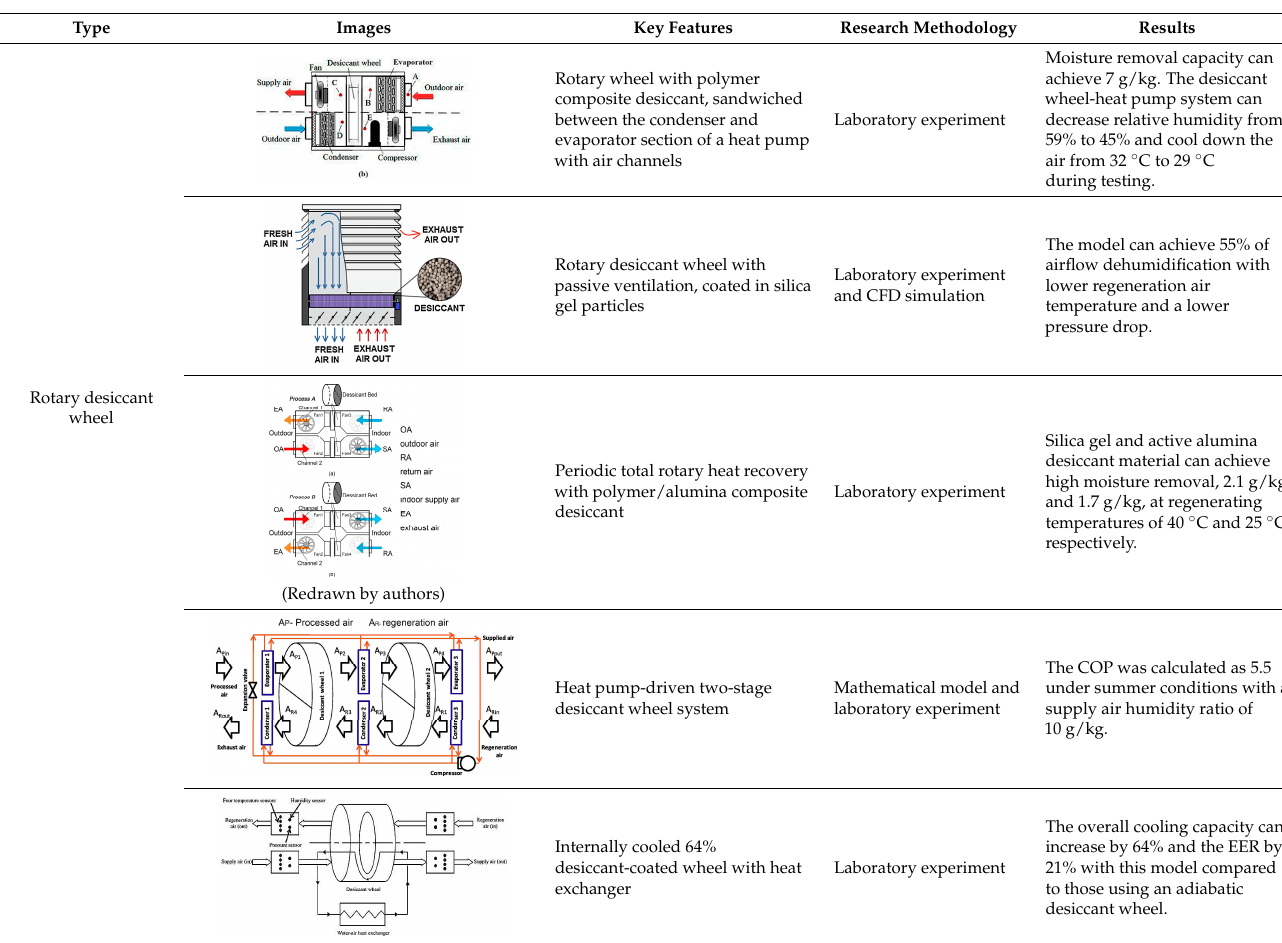
Table 3. A summary of different types of heat exchangers with dehumidification systems.